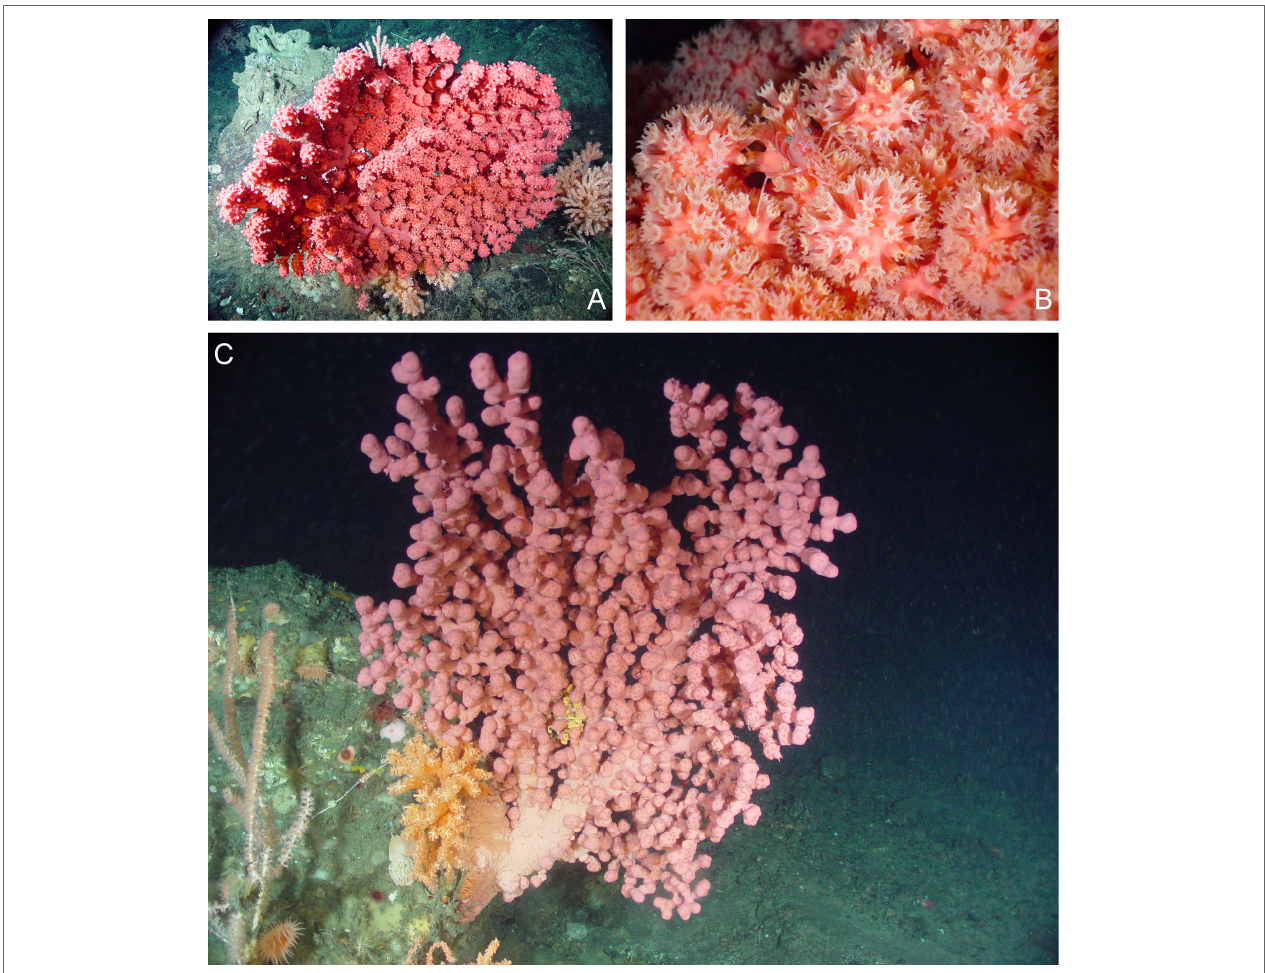
FIGURE 1 | In situ images of Paragorgia arborea from the Northeast Channel Coral Conservation Area. (A) Intact colony growing on bedrock; (B) Close up of polyps open for feeding; (C) Intact colony growing on a